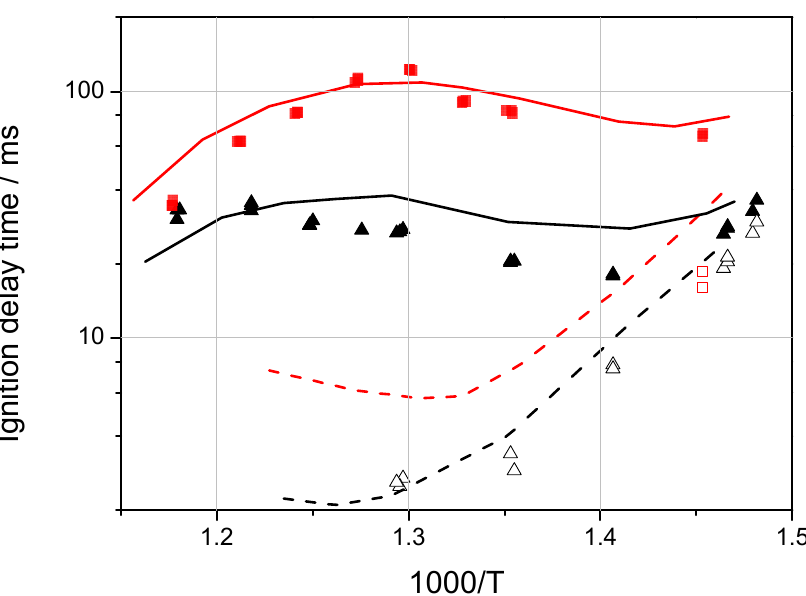
Figure 4. Experimental (symbols) and simulated (lines) evolution of the first-stage (open symbols, dashed lines) and total (full symbols, solid lines) ignition delays for stoichiometric pure iso -octane/‘air’ (black) and 80/20% mol. iso -octane- ortho -cresol/‘air’ (red) mixtures with the core gas temperature T C . P C = 20 bar.